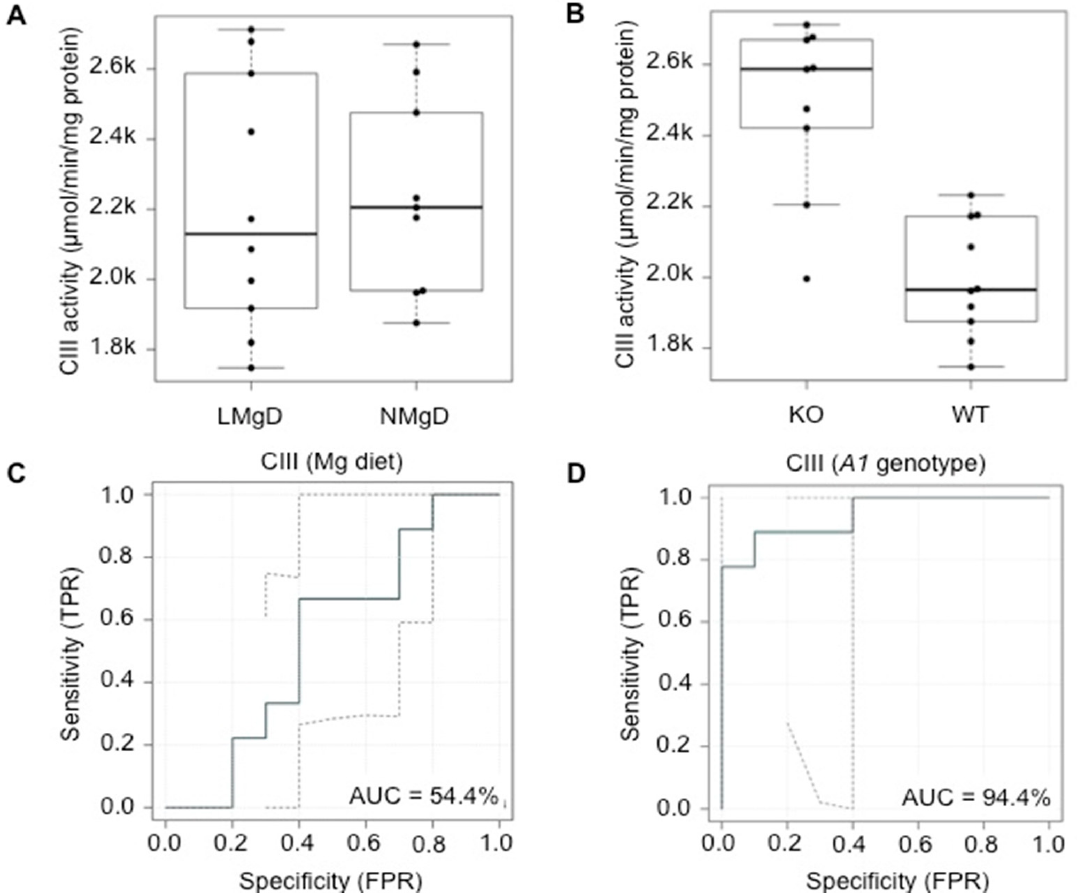
Figure 6. Impact of dietary Mg content and Slc41a1 genotype on the activity of complex III (CIII) in murine cardiac mitochondria ( A ) Box-and-whisker plot overlaid with dot plot showing the influence of dietary Mg content (LMgD vs. NMgD) and ( B ) Slc41a1 genotype ( Slc41a1 − / − vs. Slc41a1 +/+ ) on CIII activity in murine mitochondria. For both, A and B, the original source data and corresponding medians are indicated for each group. ( C , D ) Empirical ROC (receiver operating characteristic) curves with the area under the ROC curve (AUC) for ( C ) the type of Mg diet as predictor of CIII activity and ( D ) the Slc41a1 genotype as predictor of CIII activity. Abbreviations: A1 , Slc41a1 ; FPR, false-positive rate; KO, knock-out; TPR, true-positive rate; WT, wild-type. For CIV (cytochrome c oxidase) activity, significant increasing effects of LMgD vs. NMgD ( p < 0.001; Figure 7A) and Slc41a1 − / − vs. Slc41a1 +/+ genotype ( p < 0.05; Figure 7B) were detected in cardiac mitochondria. However, a highly significant interaction ( p < 0.001) between dietary Mg content and Slc41a1 genotype indicated a strong interdependence of the two factors. As such, no significant difference ( p = 0.064) of CIV activity was detected in cardiac mitochondria when Slc41a1 +/+ animals on LMgD were compared with Slc41a1 +/+ animals on NMgD (LMgD 745 ± 20 nmol/min/mg protein vs. NMgD 597 ± 25 nmol/min/mg protein; Figure A1). By contrast, the CIV activity was increased in cardiac mitochondria by 186.1% ( p < 0.001) in Slc41a1 − / − animals on LMgD when compared to Slc41a1 − / − animals on NMgD (LMgD 1070 ± 22 nmol/min/mg protein vs. NMgD 374 ± 20 nmol/min/mg protein; Figure A1). Moreover, cardiac mitochondria of Slc41a1 − / − animals had 37.4% lower CIV activity on NMgD ( p < 0.01) and 43.6% higher CIV activity on LMgD ( p < 0.001) when compared with cardiac mitochondria from A1 +/+ animals (Figure A1). The eROC analyses revealed 97.8% and 44.4% ability of the type of Mg diet and of Slc41a1 genotype to serve as discriminants/predictors of CIV activities, respectively (Figure 7C,D); the uncertainties of the ROC curve estimates are given in Figure 7C,D.